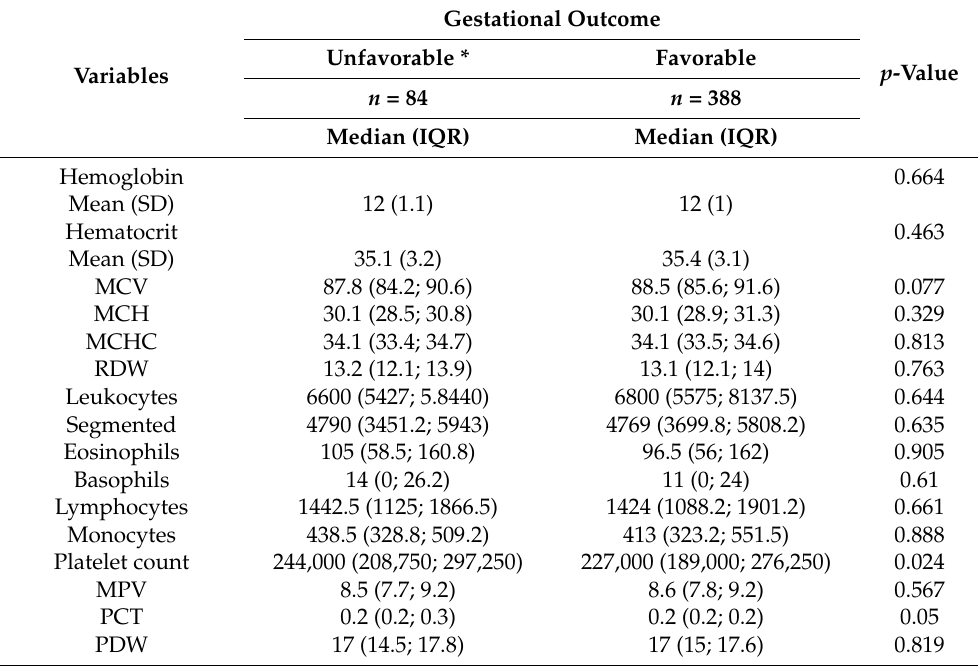
Table 3. Hematological variables according to the gestational outcome of pregnant women with exanthematic manifestations who sought care at the Foundation of Tropical Medicine Doctor Heitor Vieira Dourado, Manaus,